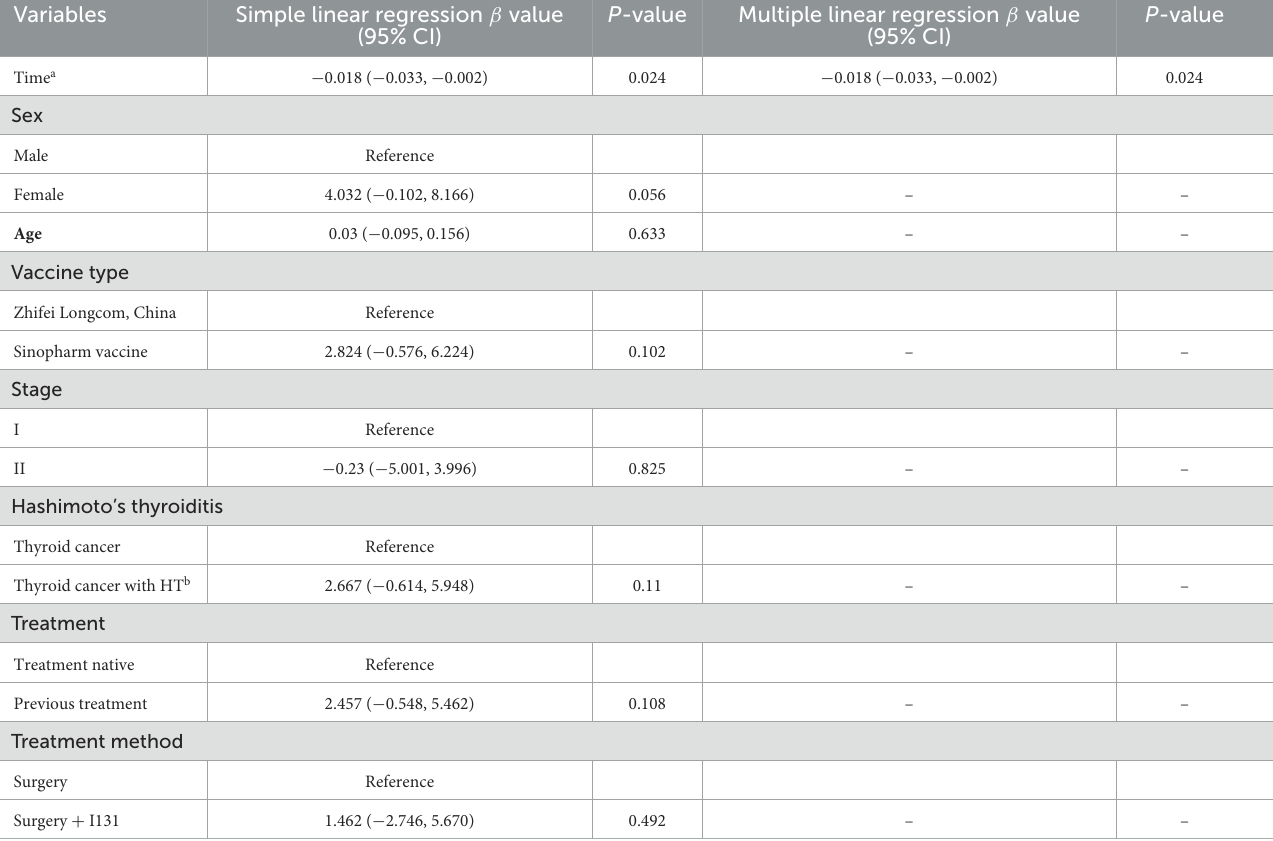
TABLE 3 Simple and multiple regression analyses to identify risk factors of lower anti-RBD titers in thyroid cancer